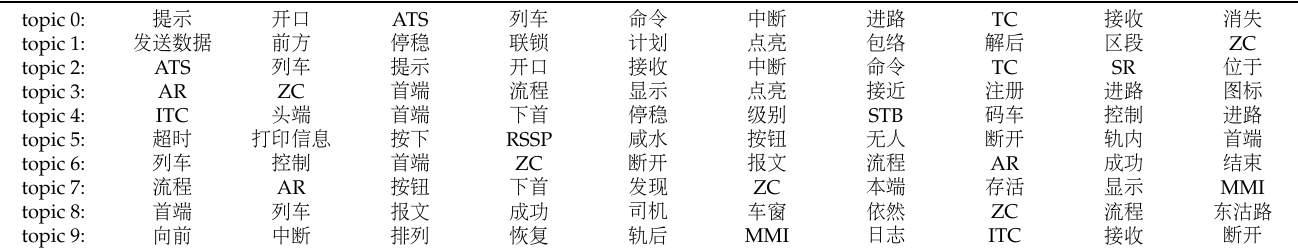
Table A1. Topic analysis of AEC in